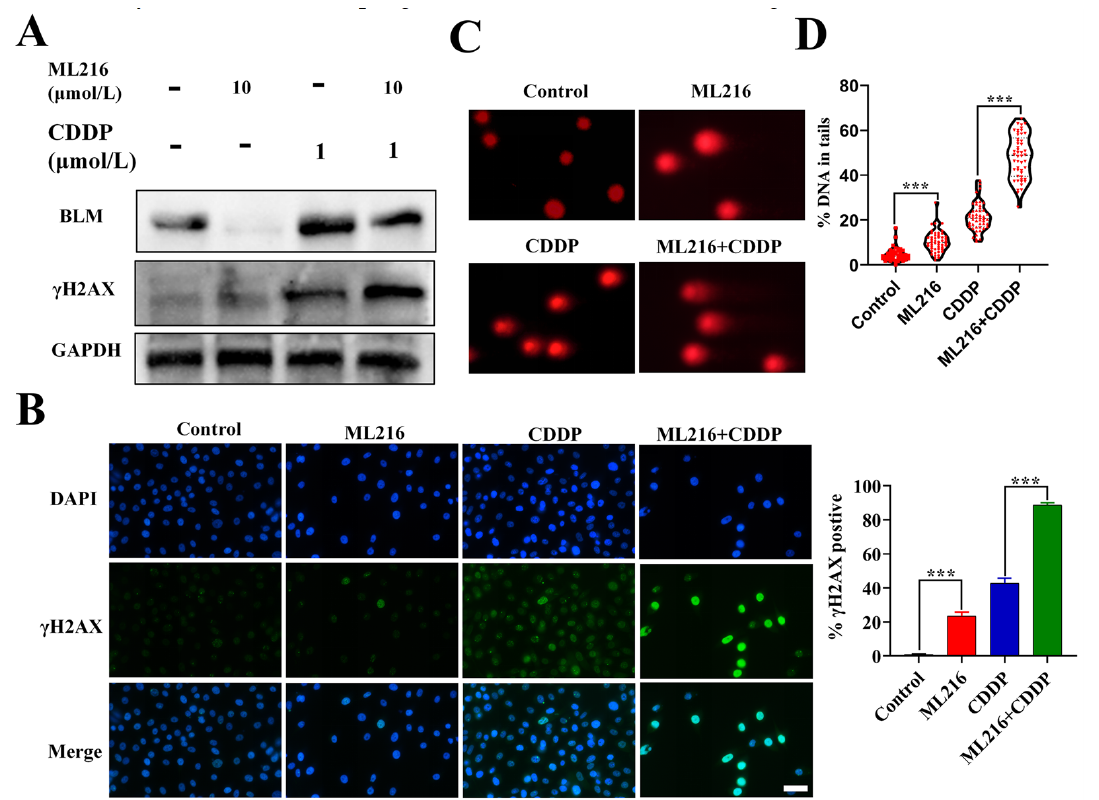
Figure 3. ML216 enhances CDDP-induced DSBs by inhibiting BLM in PC3 cells ( A ) PC3 cells were co-treated with CDDP (1 μ M) and ML216 (10 μ M) for 48 h, and WB examined BLM and γ H2AX. GAPDH was used as a loading control. ( B ) Detection of γ H2AX foci (green) 48 h after ML216 (10 μ M) and CDDP (1 μ M) treatment. Scale bars: 50 μ m. ( C ) Comet assay of PC3 cells treated with ML216 and CDDP for 48 h. Scale bars: 50 μ m. ( D ) Quantifying %DNA in tails in ML216 and CDDP-treated groups compared with the DMSO-treated group (control group). Quantification of 5 fields with 100 cells in total. (*** p < 0.001).